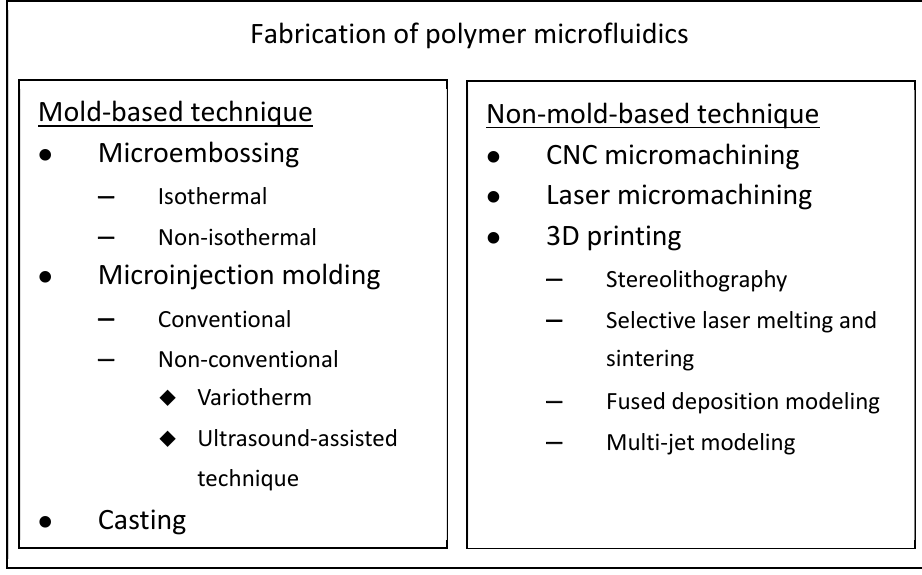
Figure 1. Fabrication techniques for polymer